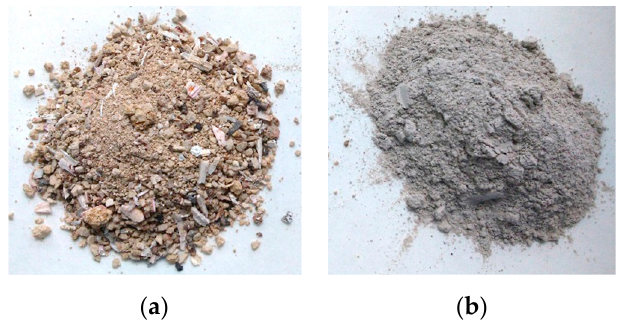
Figure 1. Ash from gasification of poultry feathers, shown before milling ( a ) and after milling ( b